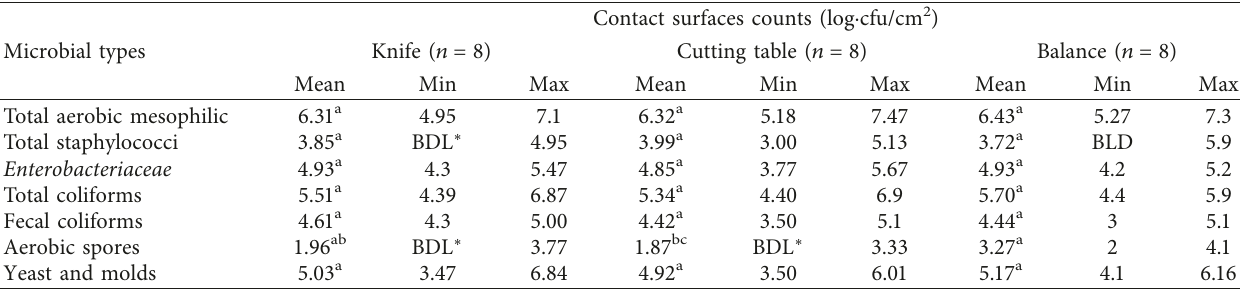
Table 3: Microbial load (log · cfu/cm 2 ) of samples from contact surface of eight butcher shops. Microbial